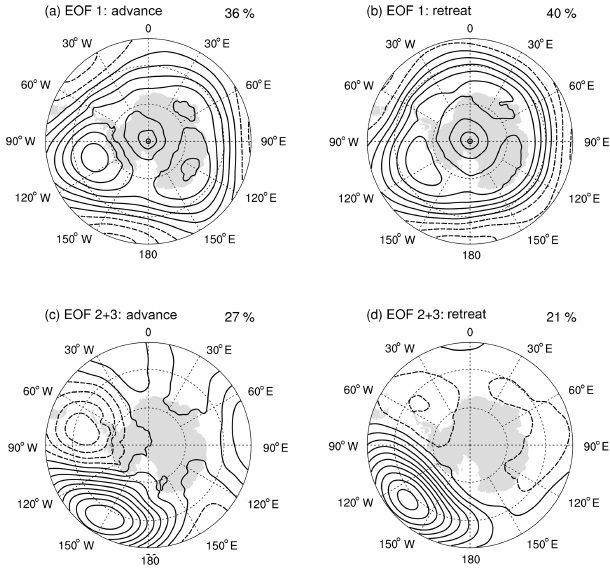
Figure 4. Eigenvectors of ERA-Interim SLP (1979–2014) in the Southern Ocean for advance (a, c) and retreat (b, d) . Numbers at top right indicate the percentage of variance in the data explained by each